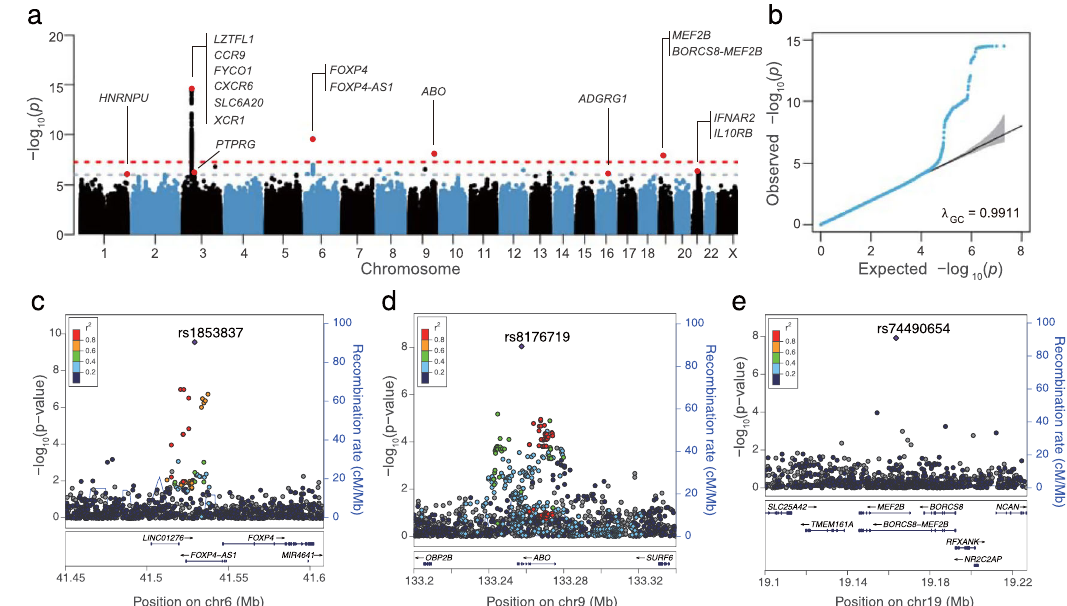
Fig. 1 Trans-ethnic meta-analysis results for severe COVID-19. a Manhattan plot of meta-analysis P values. The red dash line indicates the genome-wide signi fi cance level at P = 5 × 10 − 8 and the gray dash line indicates the suggestive signi fi cance level at P = 10 − 6 . b QQ plot, in which the gray region represents 95% con fi dence interval under the null hypothesis of no association. c – e Regional plots of three signi fi cant loci at 6p21.1, 9q34.2, and 19q13.11. The lead variant within each locus is indicated by the purple diamond while neighboring variants were colored based on LD to the lead variant in our Chinese WGS samples. Gray color indicates LD information is not available.